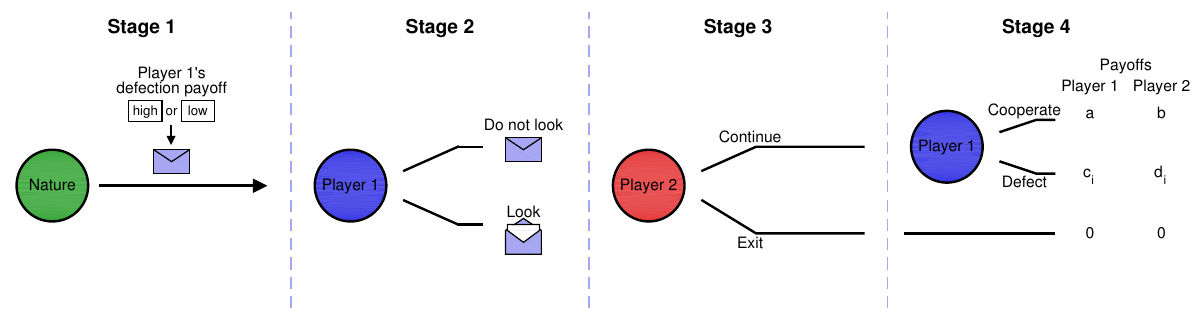
Figure 1. Schematic representation of the non-repeated envelope game. We consider a game with four stages, involving two players. In the first stage of the game, nature randomly determines Player 1’s payoff from defection, which can be either high ( h ) or low ( l ). Nature puts the respective information into an envelope. In the second stage, Player 1 is given the chance to learn the realized payoff by opening the envelope. In the third stage, Player 2 decides whether to exit the interaction, depending on whether Player 1 knows the realized payoffs. If Player 2 continues, there is a fourth stage in which Player 1 decides whether or not to cooperate. We assume that if Player 1 defects, the payoffs of both players, c and d , depend on the state of nature i ∈ { l, h } : when the state is h , then Player 1 has a i i > c higher incentive to defect ( i.e. , c h l